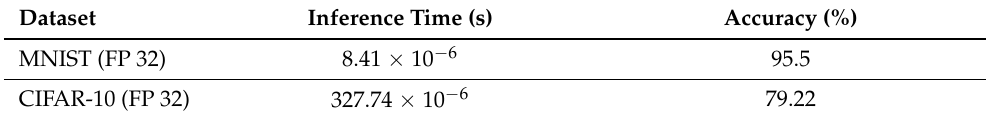
Table 5. Inference Times on the FPGA.